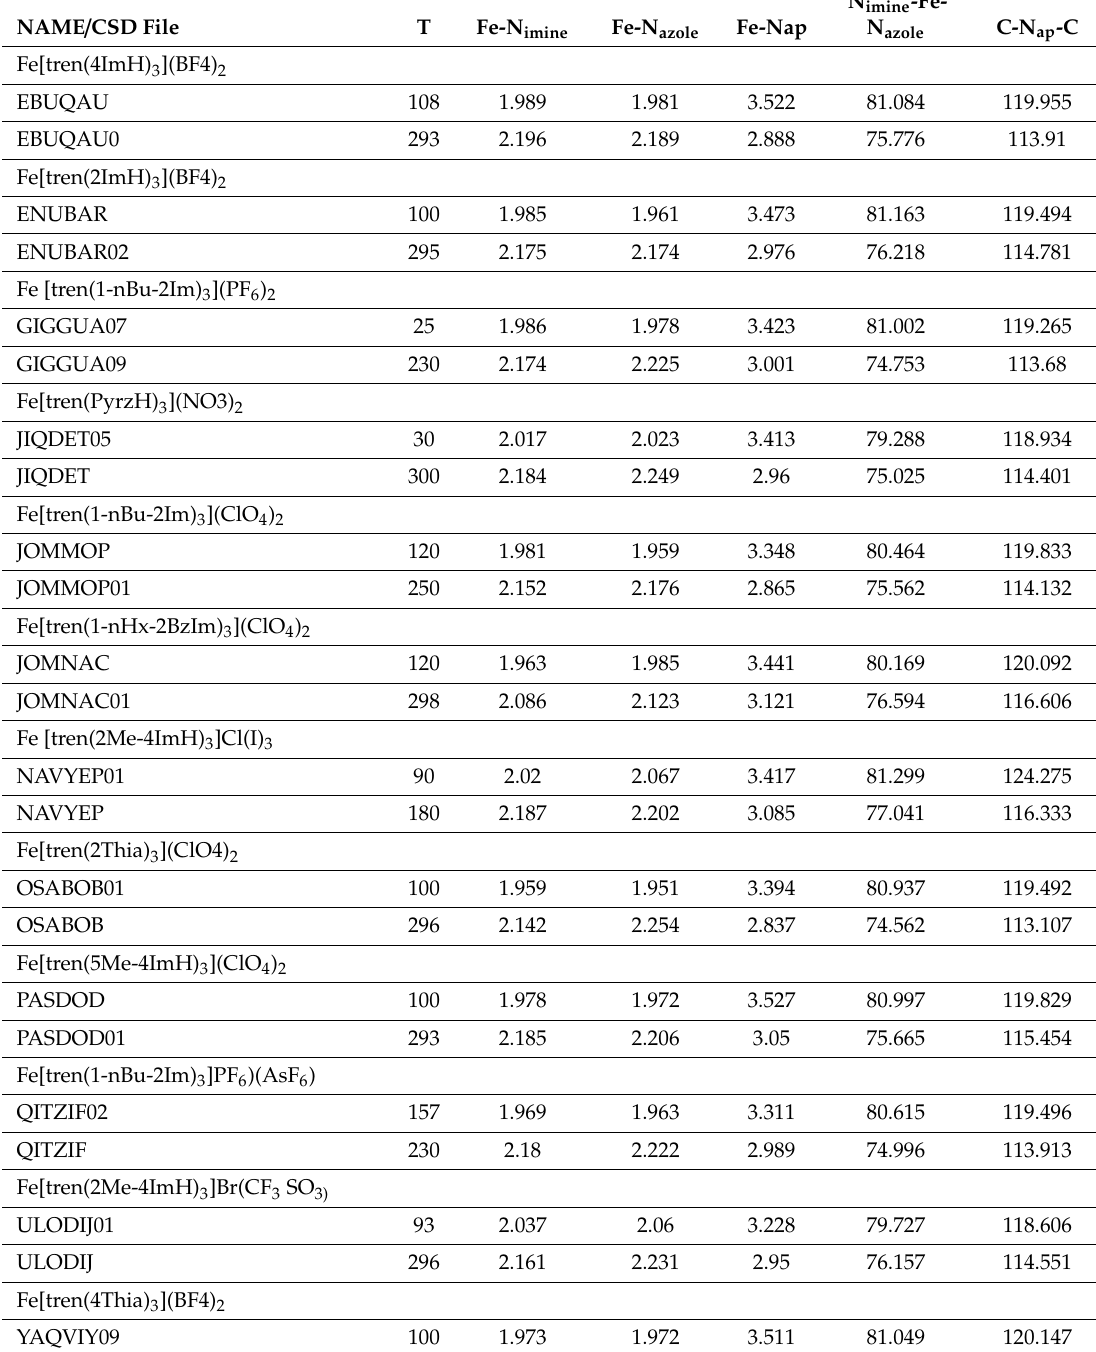
Table 3. Structural parameters, Fe-N imine , Fe-N 5 membered ring , Fe-N ap (Å) N imine –Fe-N 5 membered ring bite, and C-N ap –C angels ( ◦ ) of LS and HS iron(II) SCO complexes with Schi ff base condensates of tren with five membered ring aldehydes as